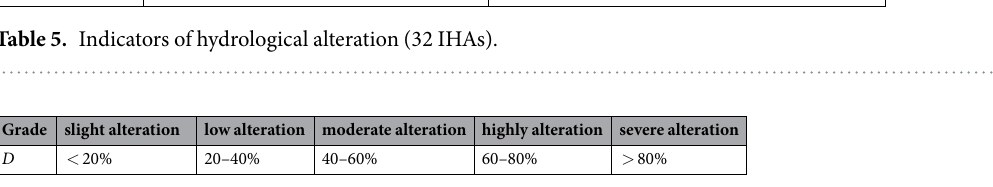
Table 6. Classification of the improved overall degree of hydrological